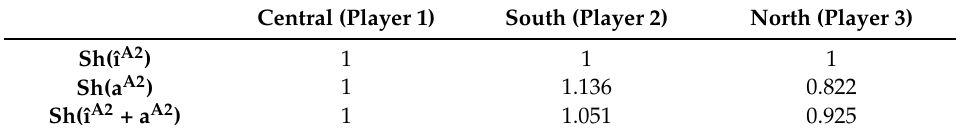
Table 27. Normalized Shapley Value payments of the investment game, and the combined